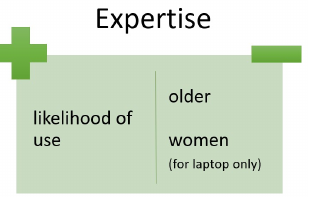
Figure 3. Regression Model: What explains